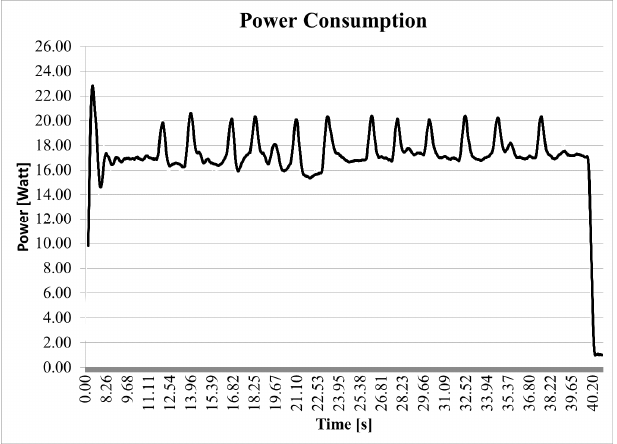
Figure 7. Measured power consumption during the test in Figure 5.